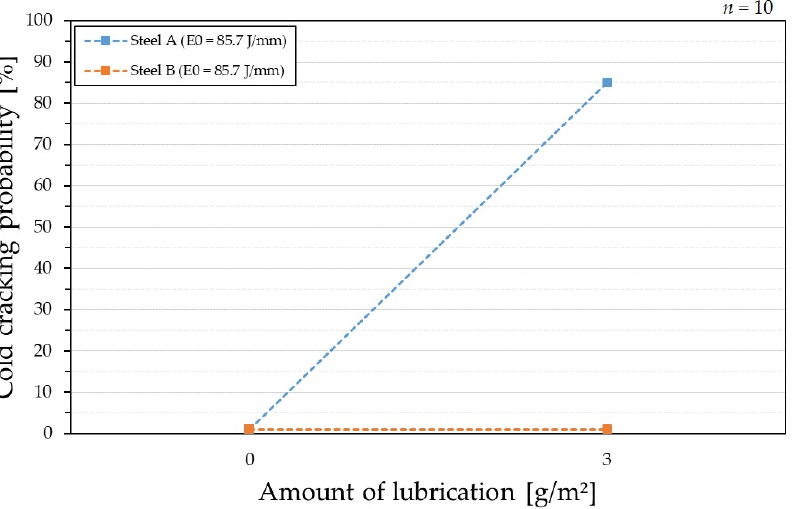
Figure 8. Comparison of the cold cracking probability between steels A and B in cleaned and lubricated condition.